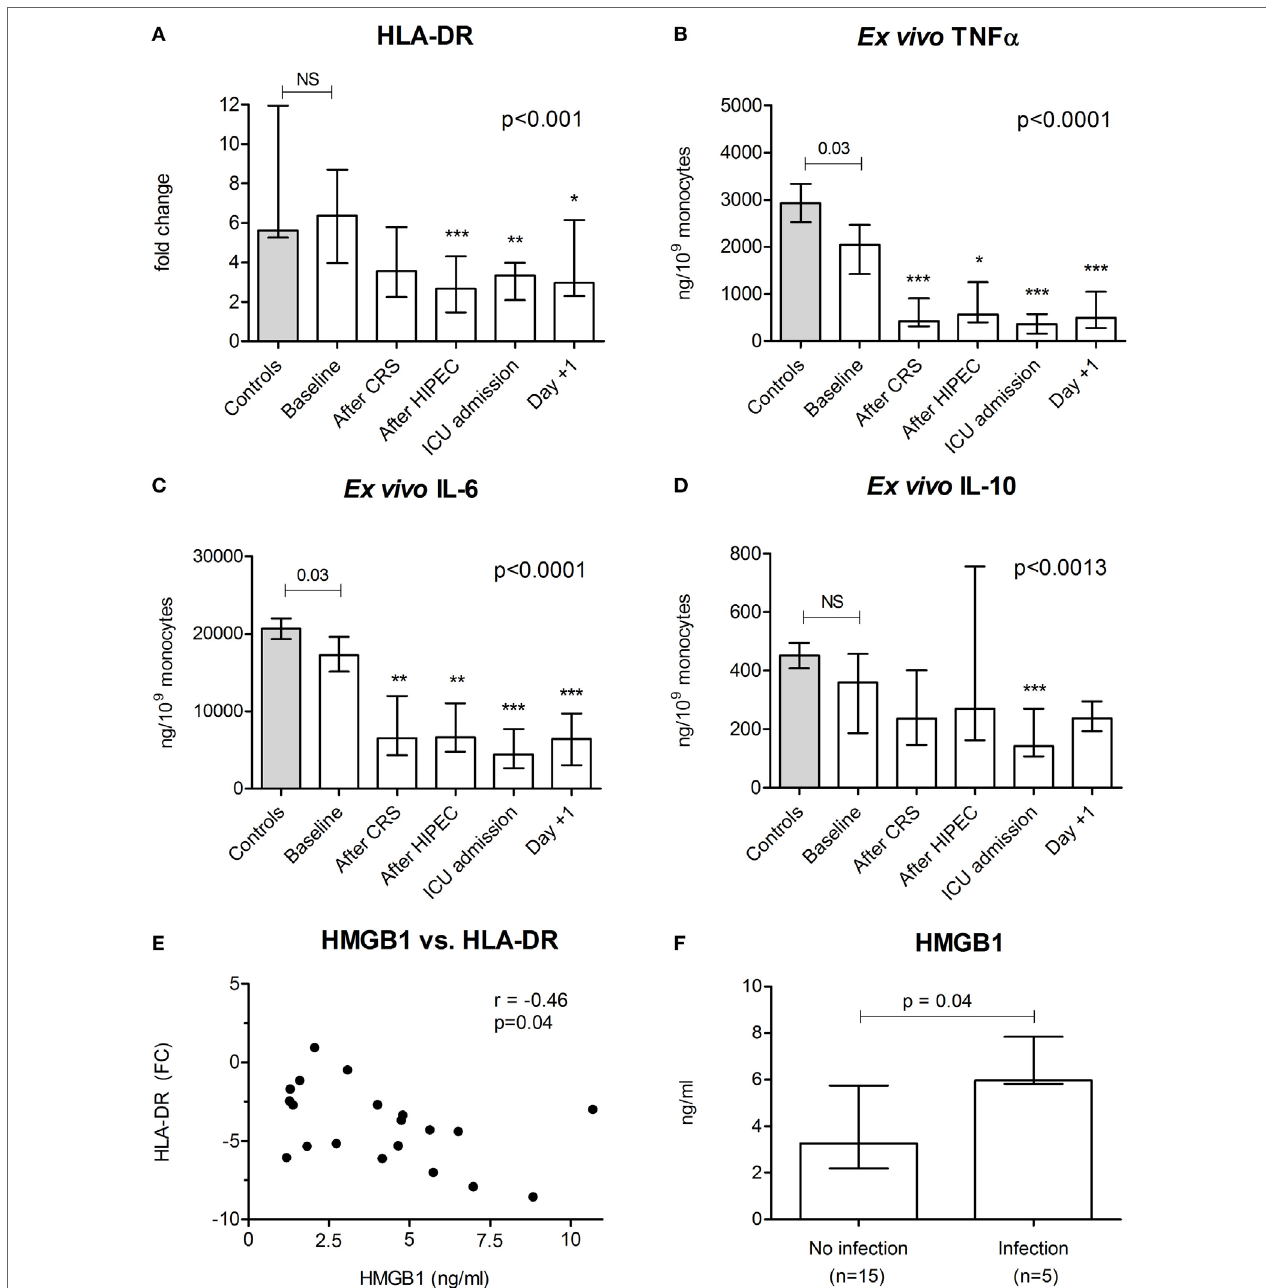
FigUre 4 | Markers of immune suppression and postoperative infections. (a) HLA-DR gene expression in leukocytes and production of (b) tumor necrosis factor α , (c) interleukin (IL)-6, and (D) IL-10 by leukocytes ex vivo stimulated with lipopolysaccharide in healthy controls ( n = 12) and in patients ( n = 20) at baseline and at various time points during and after the CRS-HIPEC procedure. (e) Correlation between the maximum increase in high mobility group box (HMGB)1 and the maximum decrease in HLA-DR expression. (F) Peak HMGB1 plasma levels between patients who went on to develop a postoperative infection and patients who did not. HLA-DR levels are depicted as fold change compared to reference gene peptidylpropylisomerase B. Data in panels (a–D) are depicted as median + interquartile range. The p -values in panels (a–D) indicating differences between controls and baseline patient in data were calculated using Mann–Whitney U -tests. The p -values in panels (a–D) indicate differences within patient data over time and were calculated using Friedman tests with Dunn’s post hoc tests (* p < 0.05; ** p < 0.01; *** p < 0.001 compared with baseline). Spearman correlation was used in panel (e) . The p -value in panel (F) was calculated using the Mann– Whitney U -test. Abbreviations: NS, not significant; CRS, cytoreductive surgery; HIPEC, hyperthermic intraperitoneal chemotherapy; ICU, intensive care unit; Day + 1, first postoperative